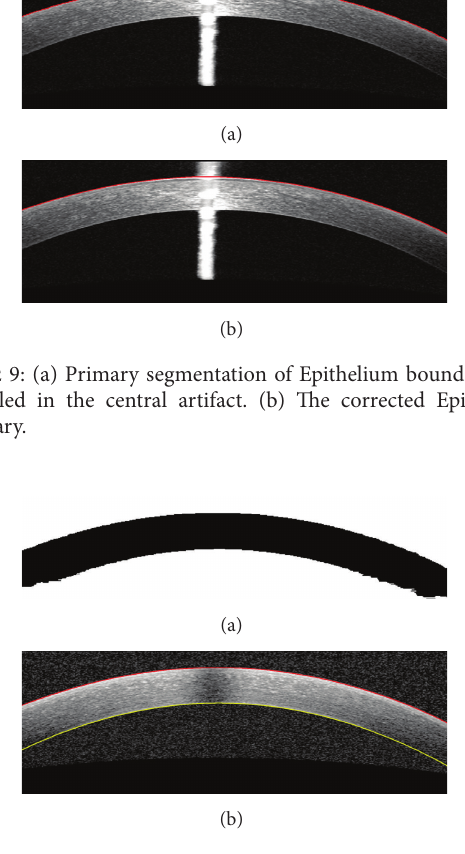
Figure 10: (a) Output of Level Set. (b) The estimated Epithelium and Endothelium